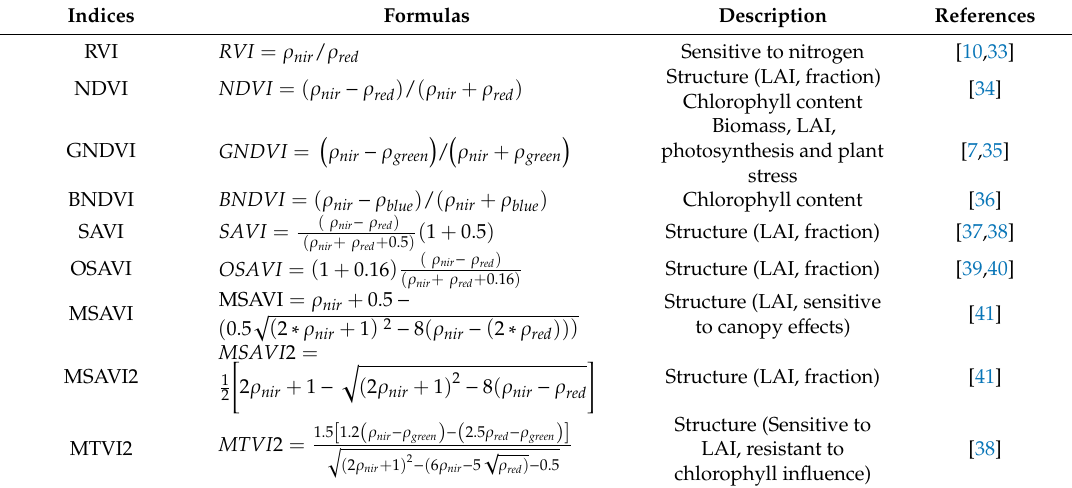
Table 1. Description and formulas of the investigated